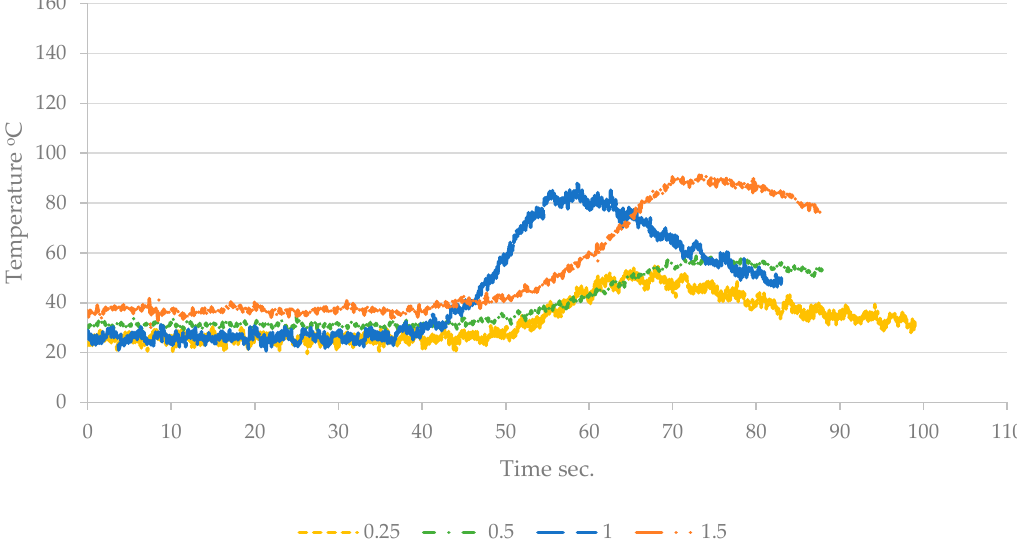
Figure 11. Effect of changing the spindle speed during the weld stroke on the temperature from R DWP = 0.25 to 1.5. It can be noticed that the cycle time changes significantly with R DWP variation in the case of the feed rate. At the same time, the cycle time remains almost fixed in the case of the spindle speed. This is because for a fixed stroke length (5 mm), the cycle time is the function of the feed rate, and is not affected by the spindle speed, as given in Equation (1). The